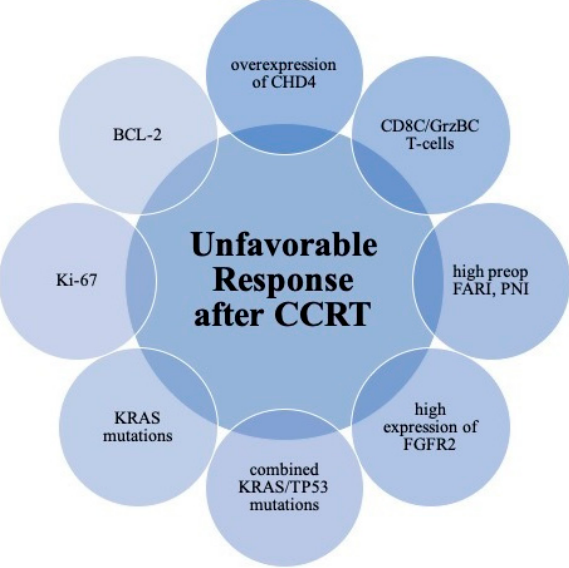
Figure 2. Schematic diagram of unfavorable biomarkers for neoadjuvant concurrent chemoradiation in patients with locally advanced rectal cancer. Abbreviations: CCRT, concurrent chemoradiation; preop, preoperative; FARI, Fibrinogen-Albumin ratio index; PNI, Prognostic Nutritional Index; FGFR, fibroblast growth factor receptor.